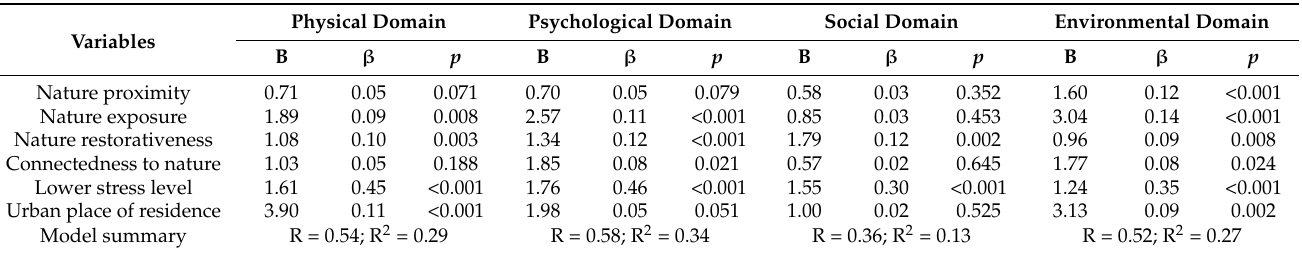
Table 3. Multiple linear regression models to predict the domains of quality of life by the study variables (n =